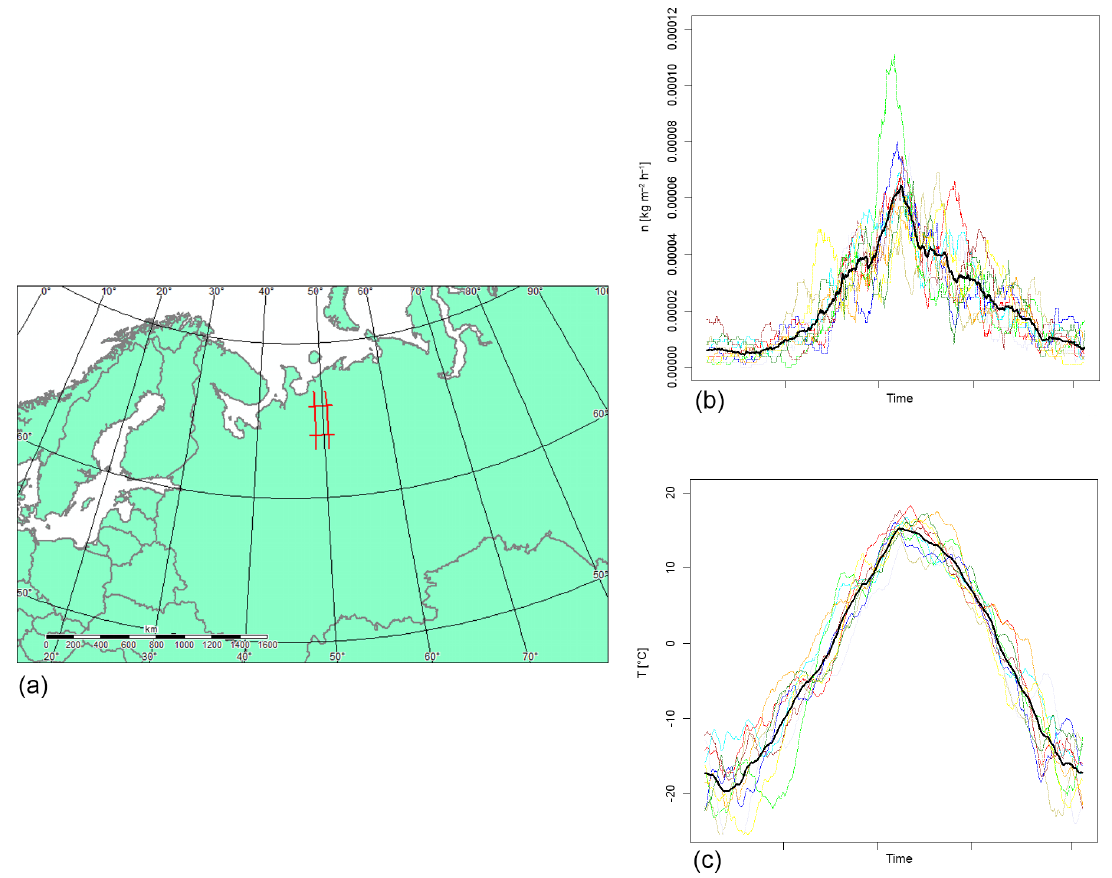
Figure 3. Location (a) and annual variations of precipitation (b) and temperature (c) for 9 years of the Timan Ridge, Russia, derived from NCEP/NCAR reanalysis data (Kalnay et al., 1996). The model uses the average curves (bold black